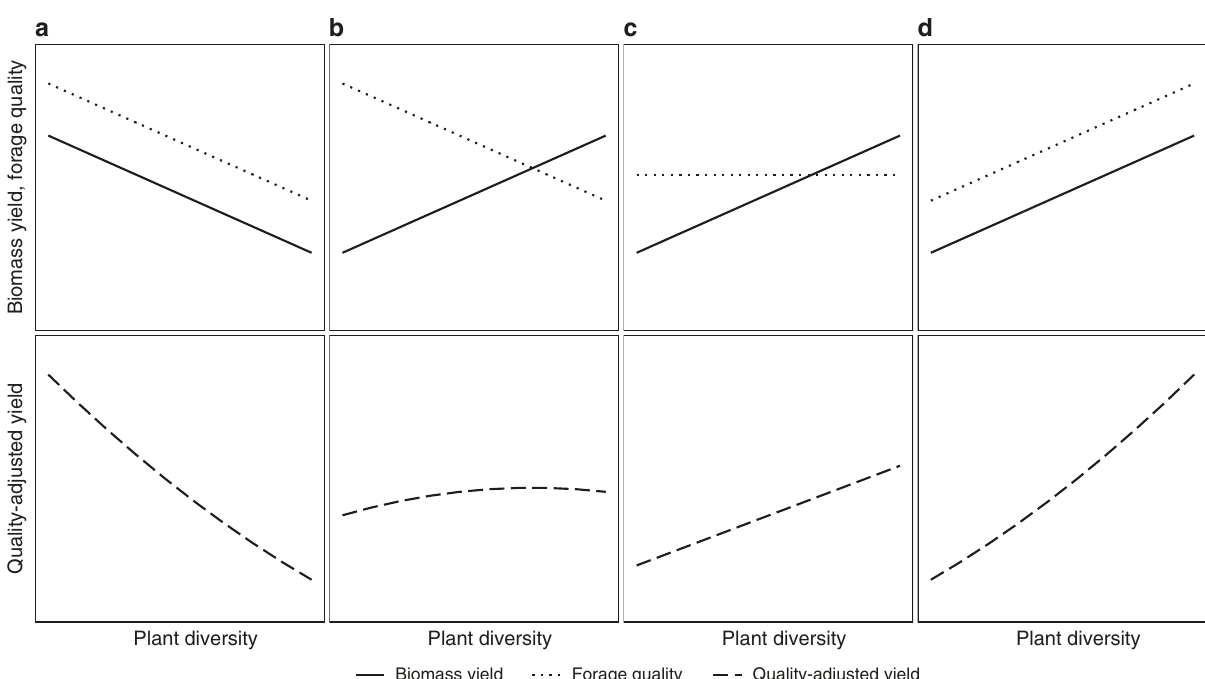
Fig. 1 Conceptual framework of the relationship between plant diversity and biomass yield, forage quality and quality-adjusted yield. The panels show the different hypotheses about the plant diversity effect on biomass yield, forage quality, and quality-adjusted yield. a Hypothesis a. b Hypothesis b. c Hypothesis c. d Hypothesis d. Source data are provided as a Source Data fi